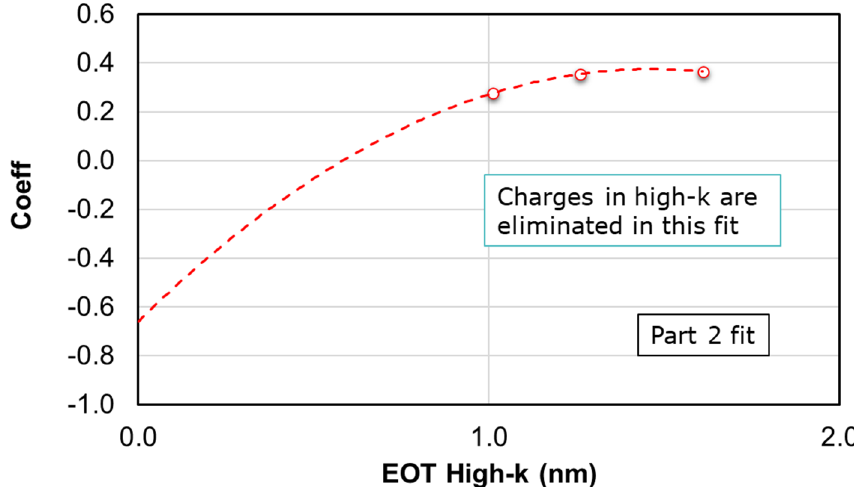
Figure 6. The V FB measured from CV is plotted as a function of SiO 2 thickness. A second order fit is performed to isolate the terms p and q containing the charge densities in its bulk and interface.